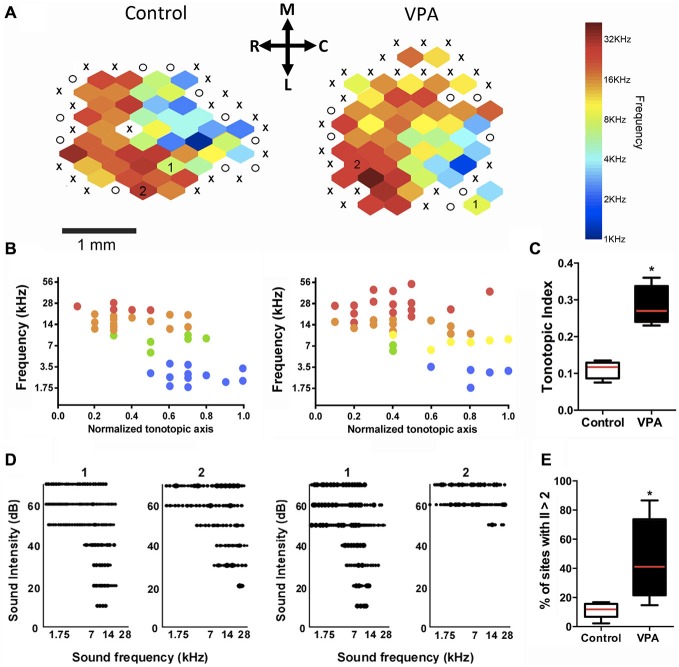
Embryonic administration of VPA alters the tonotopic organization and receptive fields of AI. (A) Tonotopic maps of a control (left) and VPA rat (right). X marks = lack of tone-evoked responses; O marks = sites outside AI. Color bar represents the spectral distribution of sound frequencies that elicited neuronal responses in AI. (B) Distribution of characteristic frequency (CF) responses plotted against the normalized tonotopic axis from representative maps shown in (A). (C) VPA animals show higher tonotopic index compared to controls, indicating a disorganization in their primary auditory cortical maps (*p < 0.01, Student’s t-test). (D) Representative receptive fields from two sites in the control and VPA maps at two different characteristic frequencies (see corresponding numbers inside each map). Note that the receptive field of VPA neuron #2 has a distinct flat peak shape and a high-threshold response for sound intensity, which contrasts to v-shaped receptive fields of AI neurons in control animals. (E) VPA animals show more sites with irregularity index (II) higher than 2, indicating a reduced relative number of v-shaped tuning curves (*p < 0.05, Students t-test). Calibration bar = 1 mm.